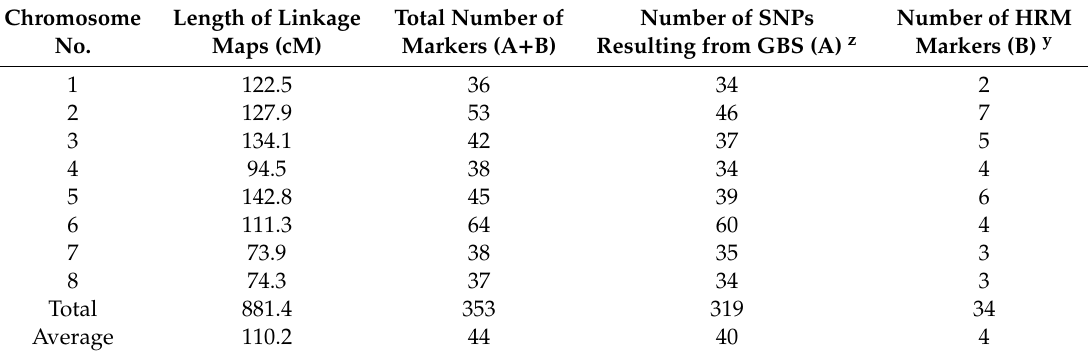
Table 4. Summary of the onion genetic linkage map constructed from an F 2 population of SP3B × H6. Chromosome